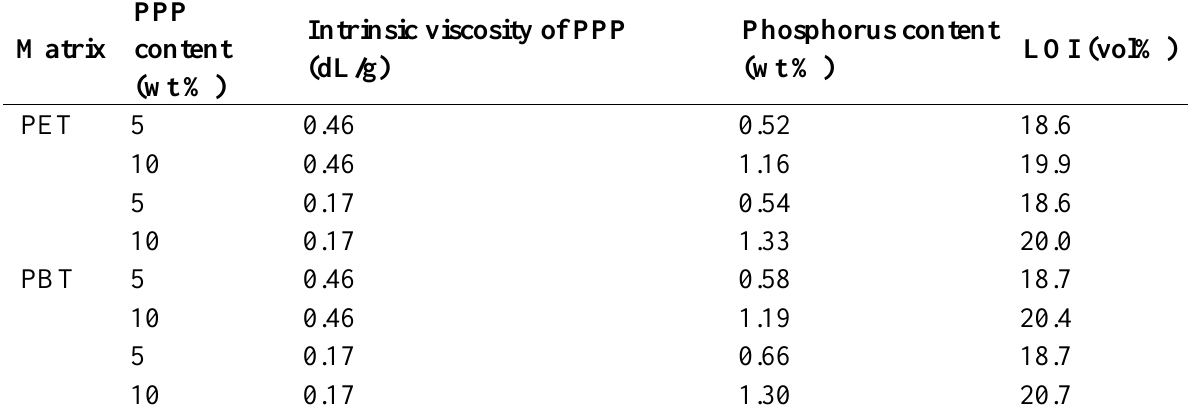
Table 2. Effect of molecular weight of poly(1,3-phenylene phenylphosphonate) (PPP) on flame retardance